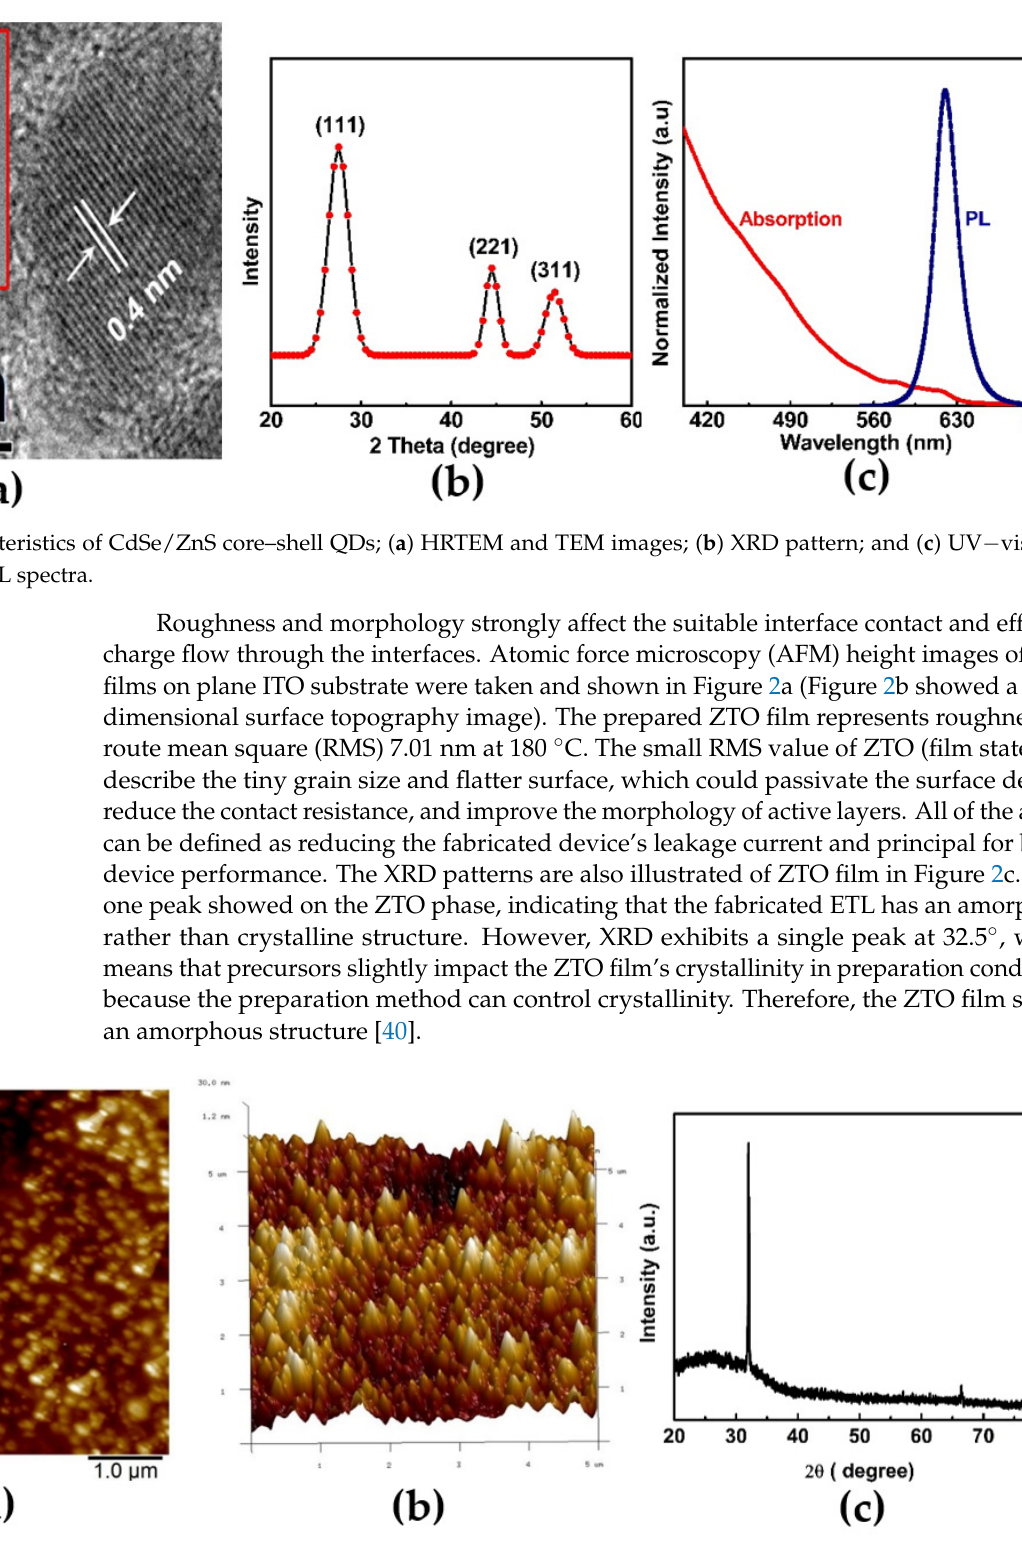
Figure 2. ZTO Characteristics ( a ) AFM height image; ( b ) 3D images; ( c ) XRD pattern.